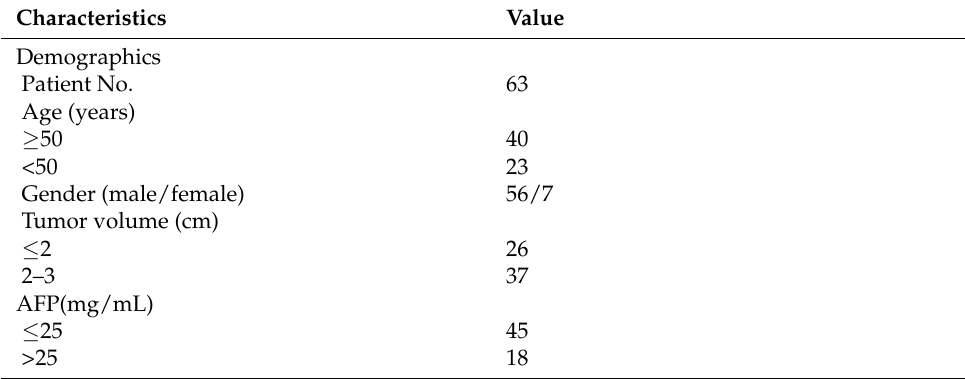
Table 1. Clinical characteristics in